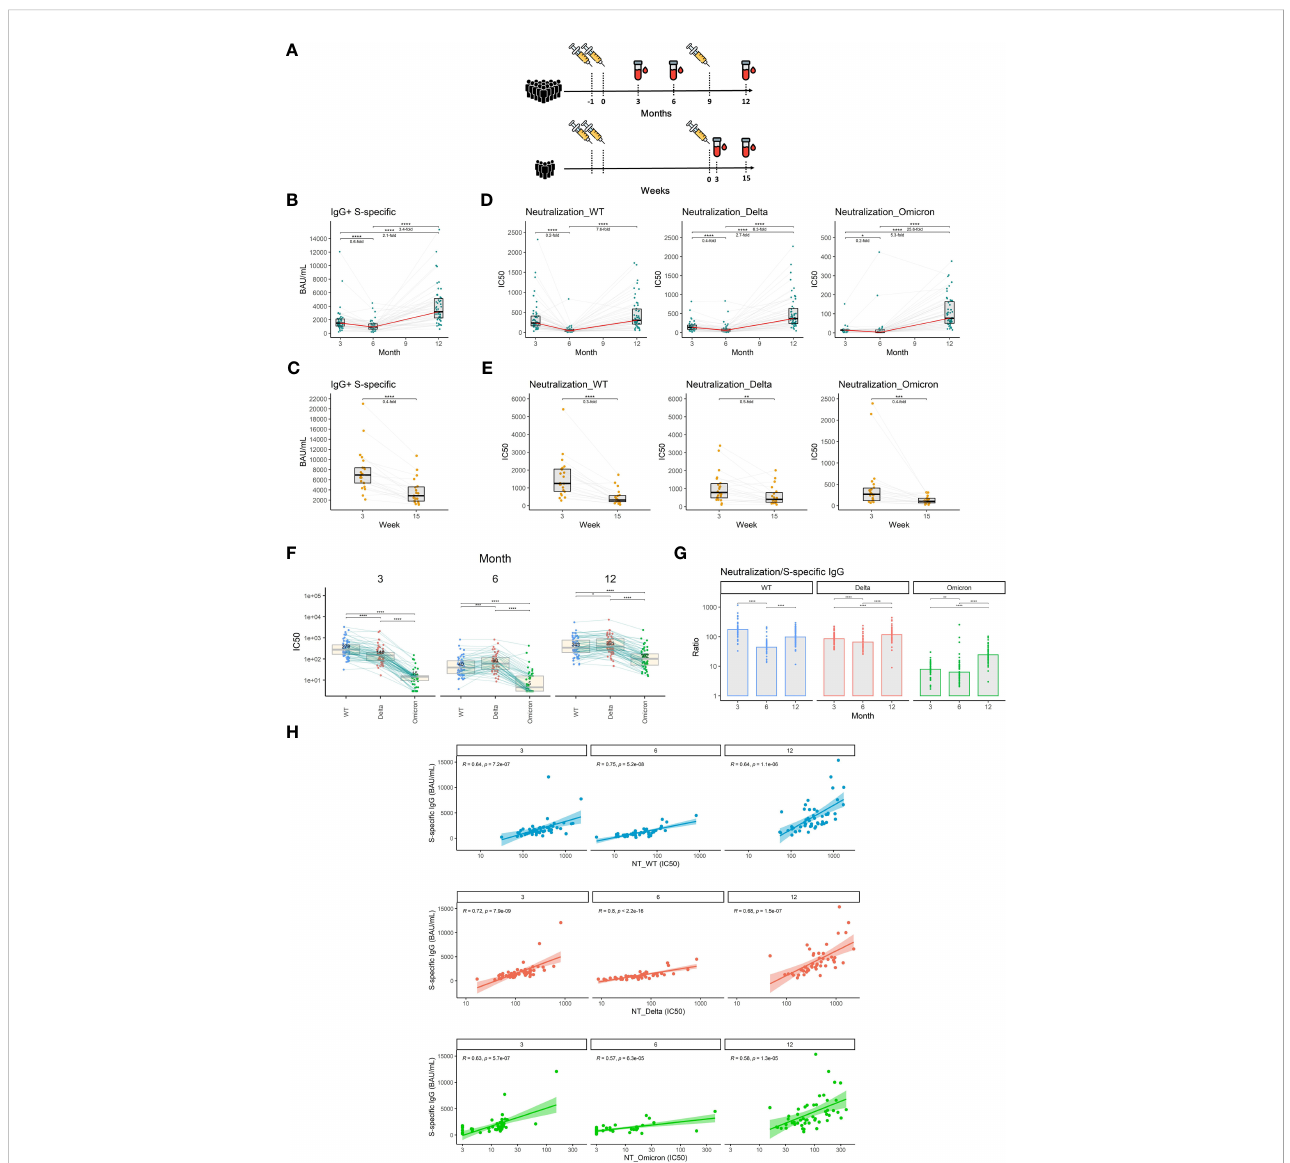
FIGURE 1 The dynamics of S1-speci fi c antibody response in plasma after the initial and booster doses of mRNA vaccine. (A) Timelines demonstrating temporal relationships between vaccination and sampling events of the study participants. (B) S1-speci fi c IgG levels in international units (BAU/mL) measured at different time points after the initial vaccination. (C) S1-speci fi c IgG levels in international units measured 3 and 15 weeks after the booster vaccination. (D) Plasma neutralization capacity measured against the wild-type, delta, and omicron variants for months 3, 6, and 12 after the initial vaccination. (E) Plasma neutralization capacity measured against the wild-type, delta, and omicron variants for weeks 3 and 15 after the booster vaccination. The red line connects the median values of each time point. Fold change was calculated as a ratio of the medians of compared time points. (F) Comparison of neutralization susceptibility of SARS-CoV-2 variants for months 3, 6, and 12. Median values are given within the boxplots. (G) Ratio between the neutralization capacity and S1-speci fi c IgG titers for different time points and different SARS-CoV-2 variants. (H) Correlation between plasma levels of S1- speci fi c IgG and plasma neutralization capacity for wild-type, delta, and omicron variants. Differences between the groups were assessed using the Wilcoxon test for matched data. Correction for multiple testing was performed using Holm ’ s method. The strength of correlations was assessed by Spearman ’ s correlation test. *p<0.05, **p<0.01, ***p<0.001,